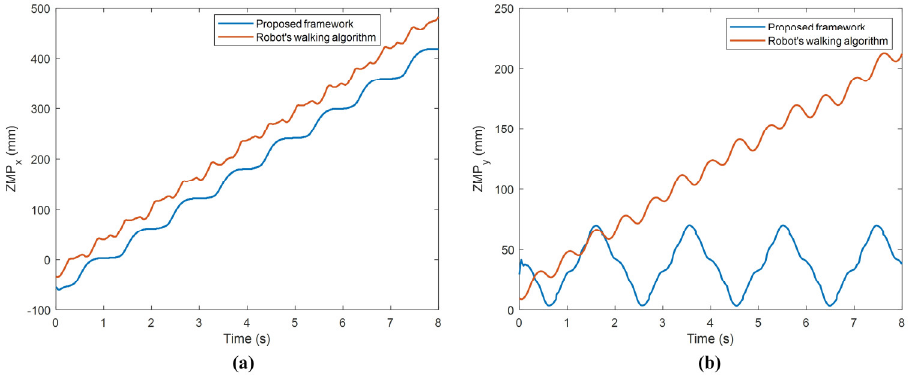
Figure 22. Comparison of ZMP values: ( a ) ZMP x , ( b ) ZMP y